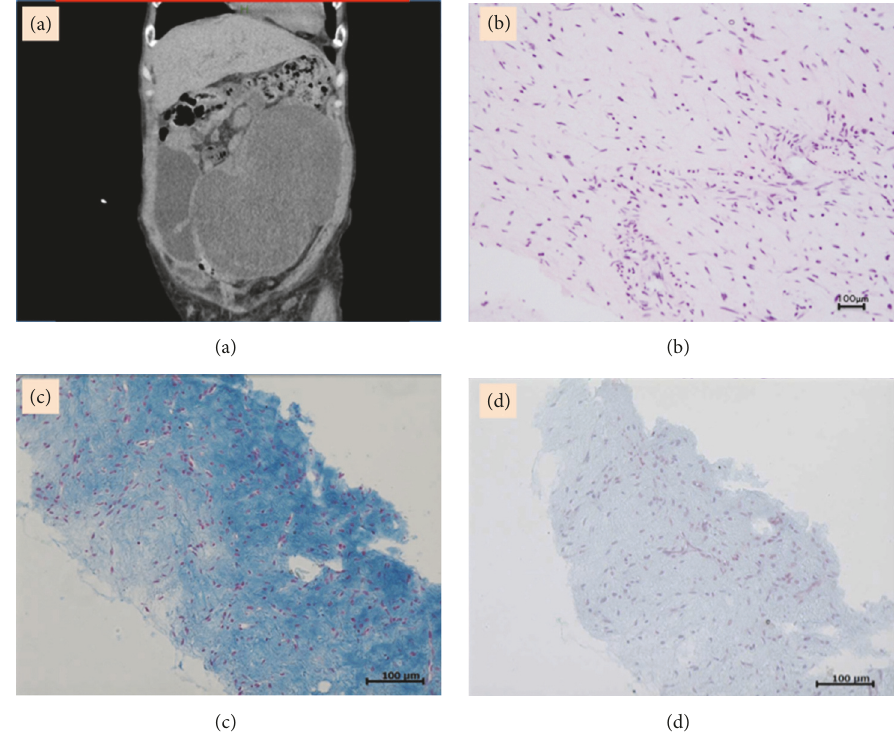
Figure 1: (a) Large tumor occupying the abdominal cavity on a computerized tomography scan. (b) The histopathological diagnosis is leiomyoma (H&E 200 × ), based on the absence of nuclear atypia and a low mitotic index. (c) Tumor cells stained strongly positive for Alcian blue at a pH of 2.5 (200 × ). (d) Alcian blue staining disappears after hyaluronidase digestion (200 ×